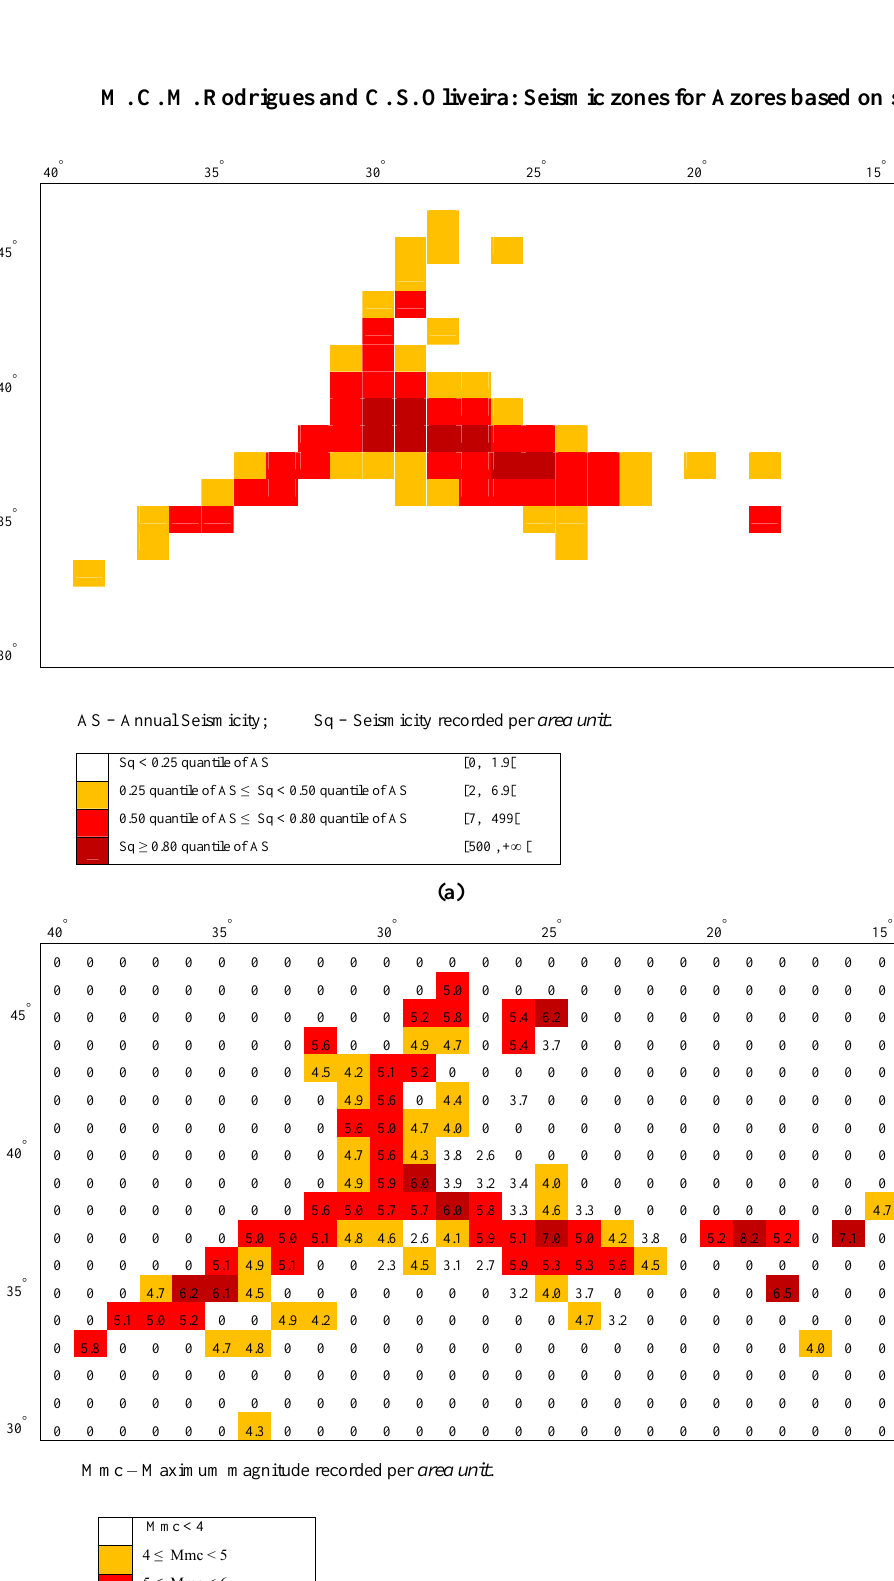
Fig. 8. (a) Seismicity recorded per area unit, and (b) maximum magnitude recorded per area